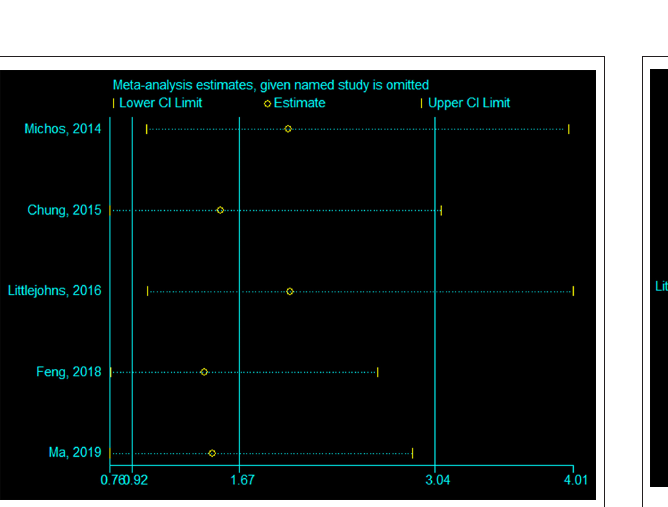
FIGURE 6 | Sensitivity analysis of insufficient vs. sufficient vitamin D